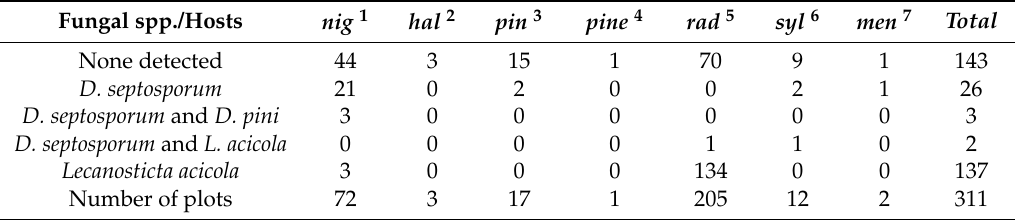
Table 2. Frequency of detection of species of Dothistroma and Lecanosticta acicola in relation to species of